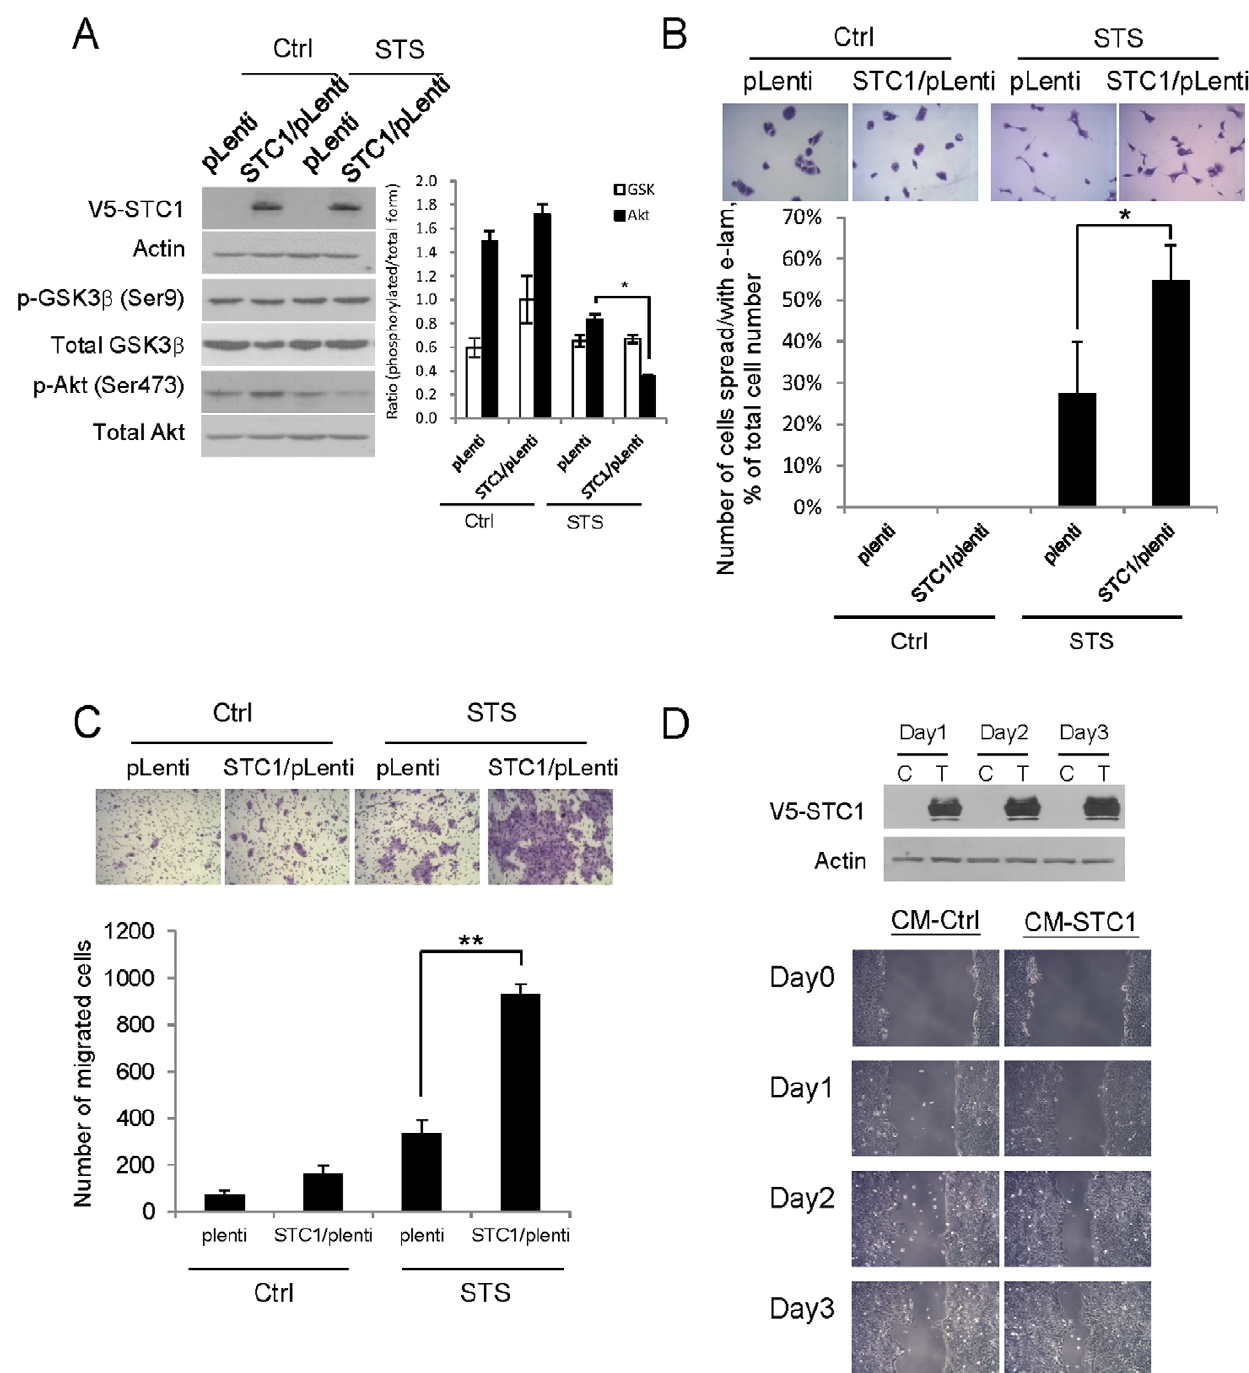
Figure 5. STC1 enhances STS-mediated re-epithelialization process. (A) After transient transfection of V5-tagged STC1/pLenti (STC1/pLenti) and empty vector control (pLenti) into the HaCaT for 24 h, the cells were treated with 5 nM STS for 24 h and the protein expression levels of V5, GSK3 b and Akt were determined using western blotting. The band intensities were measured and the ratios of the respective phosphorylated/total proteins were plotted. STC1 overexpression was found to have synergistic effect on STS-inhibited phosphorylation of Akt. STS-induced (B) e-lam formation on fibronectin-coated plate and (C) cell migration were synergistically induced by the transient overexpression of STC1 (vs STS-treated pLenti). The cell images were captured for e-lam formation (200x magnification) and cell migration (100x magnification) ( top ). (D) In the scratched wound healing assay, the scratched wound was closed significantly more rapidly in the cells maintained in the conditioned medium (CM) containing overexpressed STC1 protein (CM-STC1) than the control medium (CM Ctrl). The cell images were captured under 100x magnification. The levels of STC1 proteins in the conditioned media (CM-Ctrl and CM-STC1) were determined from day1 to day3 using western blotting. ( top ); CM-Ctrl depicts as C and CM-STC1 depicts as T. Asterisks (**) denote p , 0.01 and (*) denote p , 0.05 as compared to STS-treated pLenti-transfected cells.